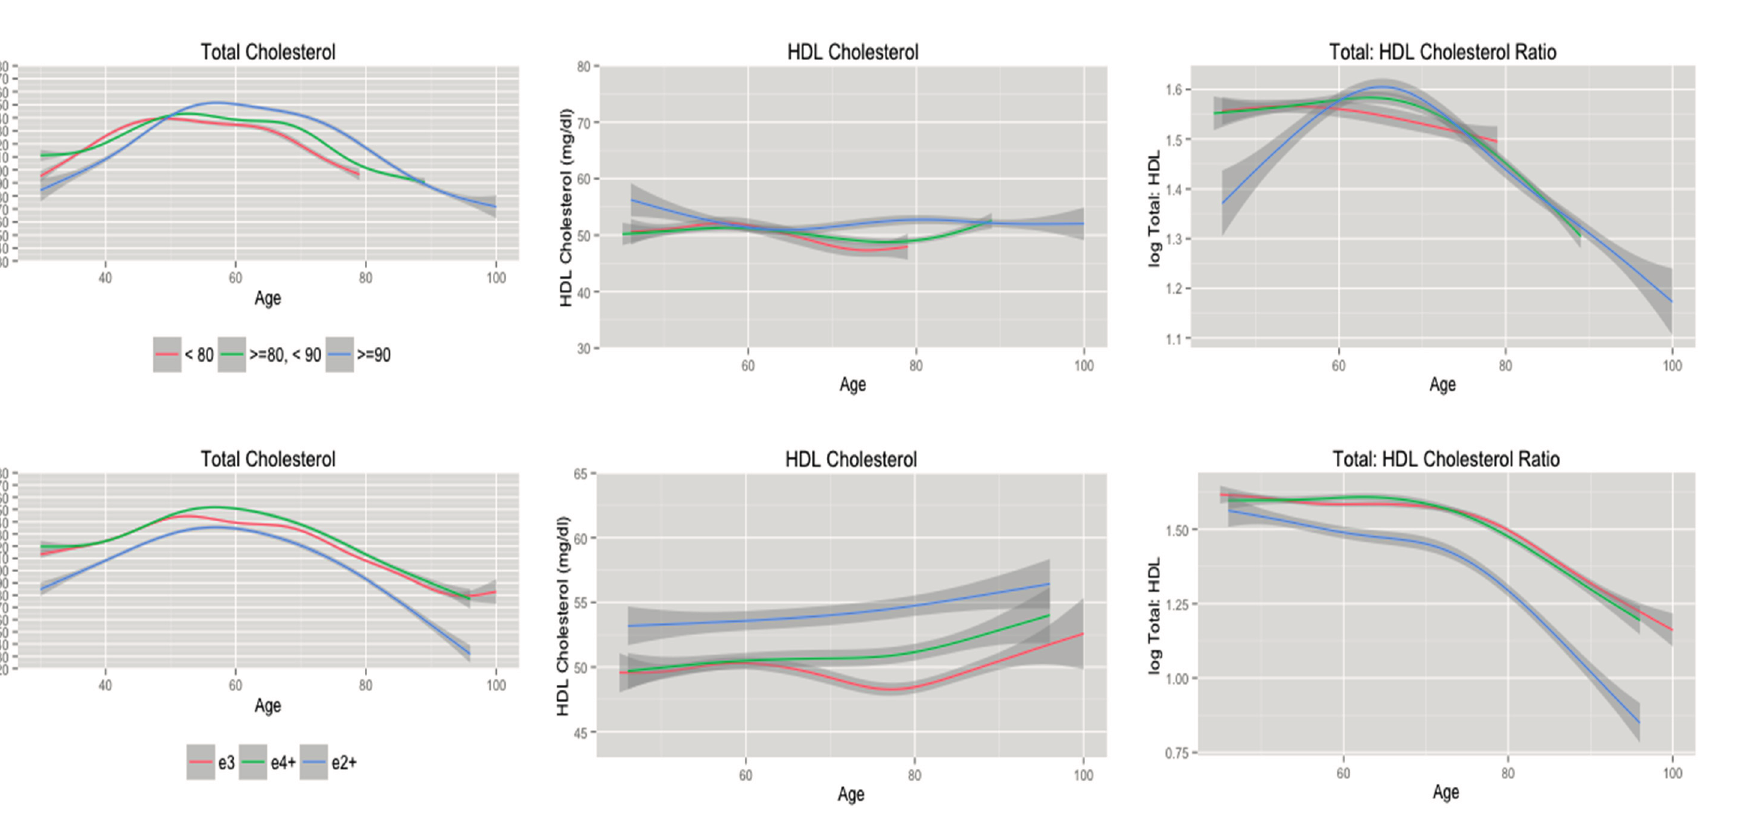
Figure 4. Cholesterol trajectories stratified according to longevity, and APOE allele status for subjects who lived beyond 80 years of